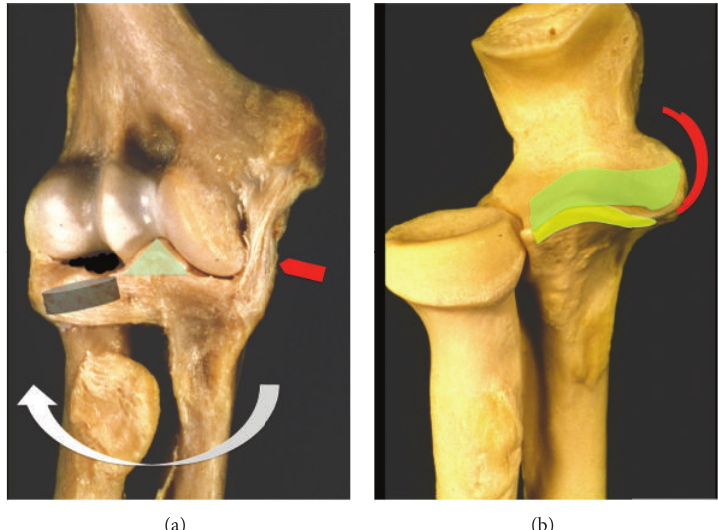
Figure 2: (a) The combined mechanical function of MUCL, anteromedial facet of the olecranon and radial head in valgus, and external rotational stability are demonstrated. (b) The yellow spot on the anatomical preparation illustrates types I and II coronoid fractures. Type III fractures of the olecranon (green spot) involve the anterior MUCL, which result in sudden angular and translational instability of the elbow between 30 ∘ and 60 ∘